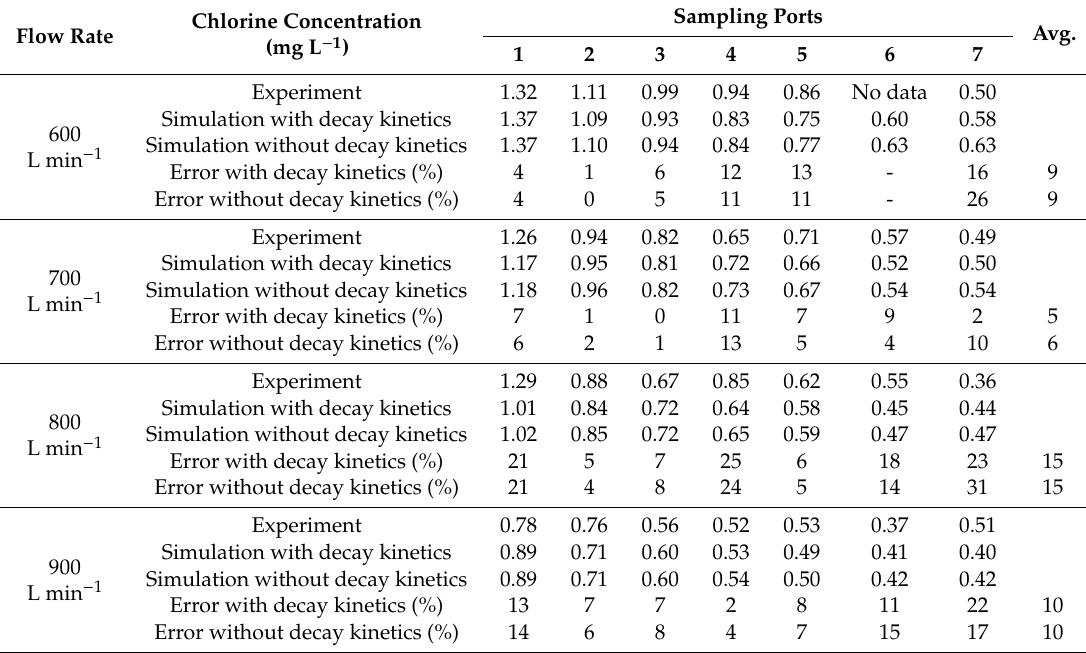
Table 2. Free chlorine concentrations in the electro-chlorination